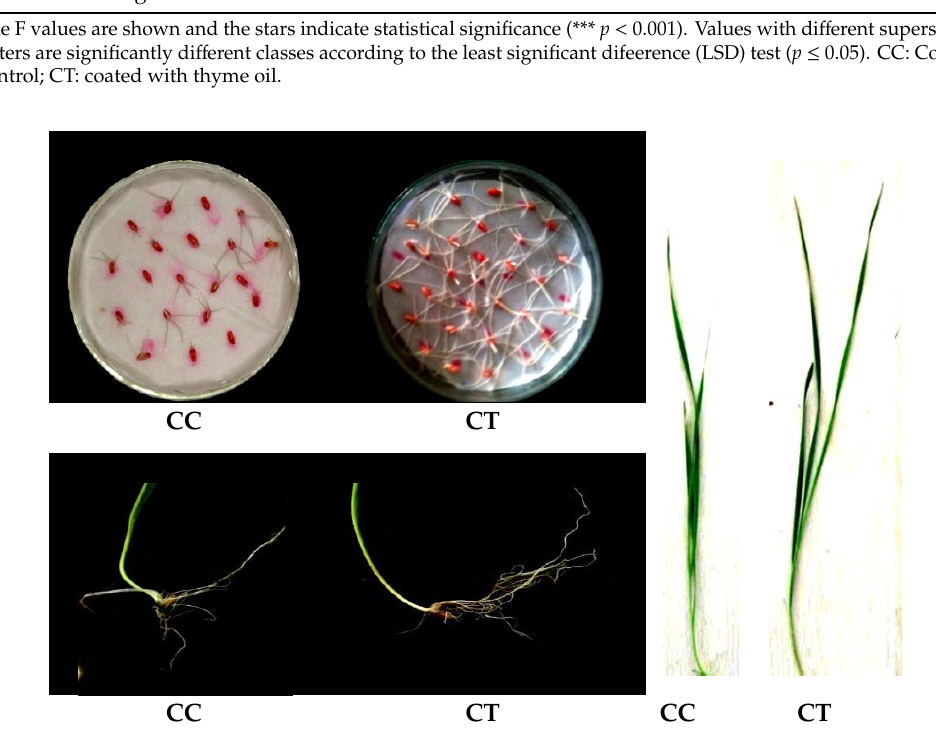
Figure 1. The E ff ects of thyme oil on seed germination and root and shoot early growth of wheat plants. Figure 1. The Effects of thyme oil on seed germination and root and shoot early growth of wheat CC: Coated control; CT: Coated with thyme plants. CC: Coated control; CT: Coated with thyme oil.